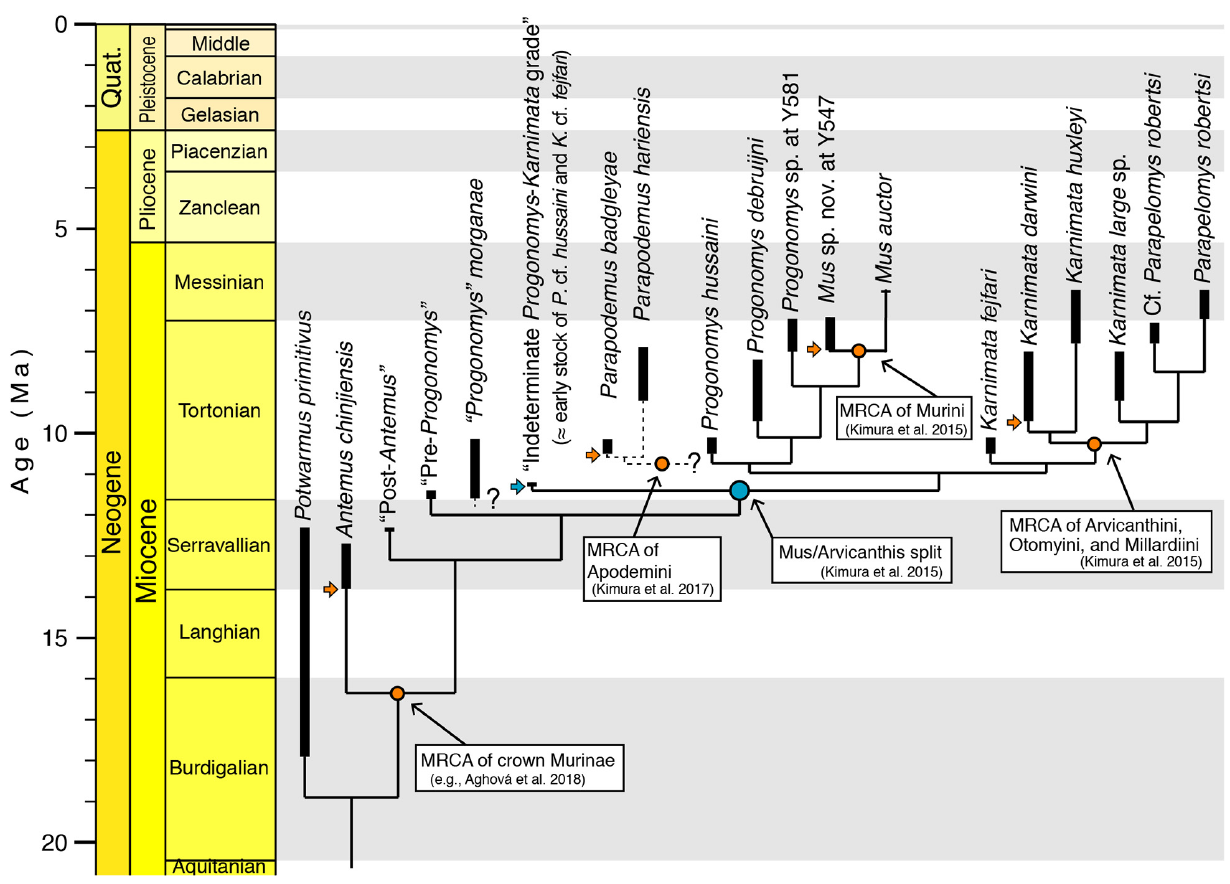
FIGURE 8 | Time-tree for proposed phylogenetic relationships of major Siwalik murine rodents with well-defined time calibration points on the standard time scale, modeled with the “ strap ” package in R (Bell and Lloyd, 2015). Stem murines Potwarmus primitivus and Antemus chinjiensis are succeeded on the tree by basal crown murines, followed by a grade labeled “indeterminate Progonomys – Karnimata ” (the cf. Progonomys hussaini and cf. Karnimata fejfari of Flynn et al., 2020). These are succeeded by the Progonomys and Karnimata clades, which are basal to subclades Murini-Praomyini-Apodemini and Arvicanthini-Otomyini-Millardiini, respectively. The bold lines connect range-through occurrences of the taxa in the Potwar record. The light blue node indicates a fossil calibration point evidenced by an initial split into two clades. The orange nodes indicate calibration points defined by the earliest occurrence of stem species of the clade. Horizontal arrows show the earliest occurrences of stem fossils. “ Strap ”-based ages of fossil calibration points are consistent with those previously proposed by Bayesian-based molecular divergence estimates in Aghová et al. (2018). Considering that the “equal” time-scaling algorithm in “ strap ” is tuned to avoid zero-length branches and that the molecular phylogeny is based on a framework of Bayesian statistics, the consistent age estimates between the two approaches indicate that Siwalik fossil sampling is dense enough to capture transitional morphological changes. Best practices for the use of fossils in molecular phylogenetics proposed by Parham et al. (2012) and followed by Aghová et al. (2018) yield credible divergence estimates for the Murinae tree. MRCA: most recent common